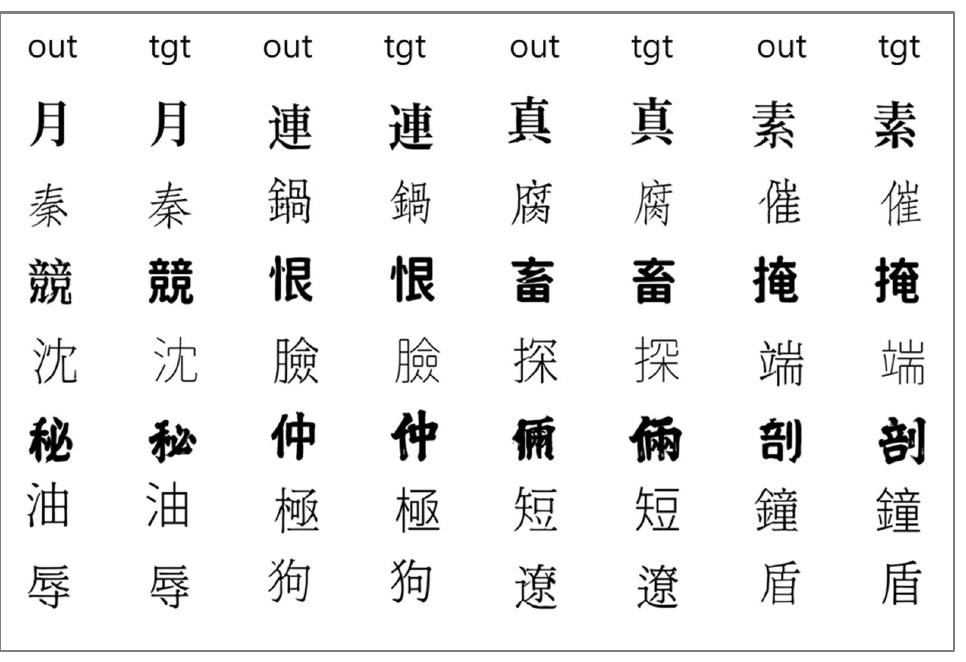
Figure 16. Sample output images of the TC characters generated.